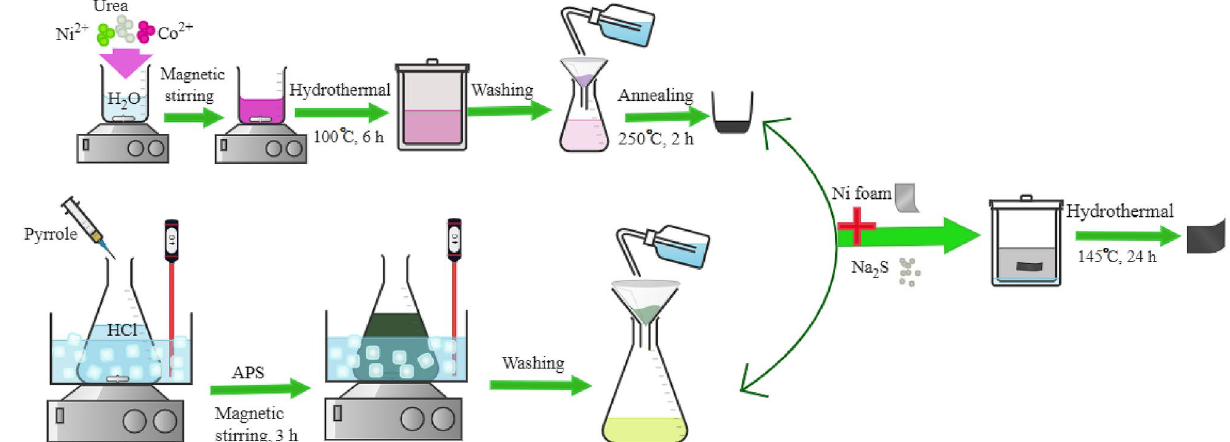
Figure 1. Schematic representation of NiCo 2 S 4 @PPy nanomaterial fabrication.